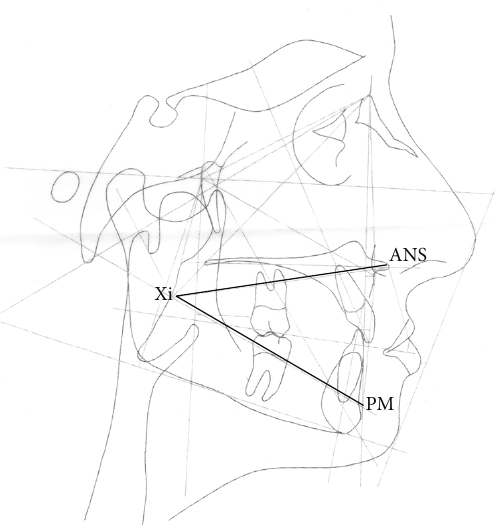
Figure 1: Lower face height (LFH) from the Ricketts lateral cephalometric analysis = angle between the planes formed by the anterior nasal spine to Xi point (ANS-Xi) and the Xi point to protuberance menti (Xi-PM). Coadjutant parameter to OVD reestablishment.